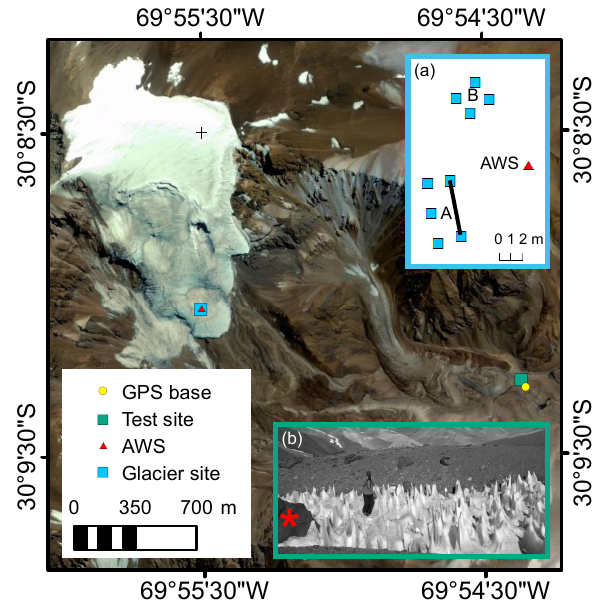
Figure 1. Map of Tapado Glacier in the Elqui catchment of the Co- quimbo Region of Chile, showing the location of the measured sites and insets of (a) the glacier site layout, showing the location of the horizontal reference (black line), and (b) the test site, indicating the boulder (red star) at which the Kinect scans were compared against